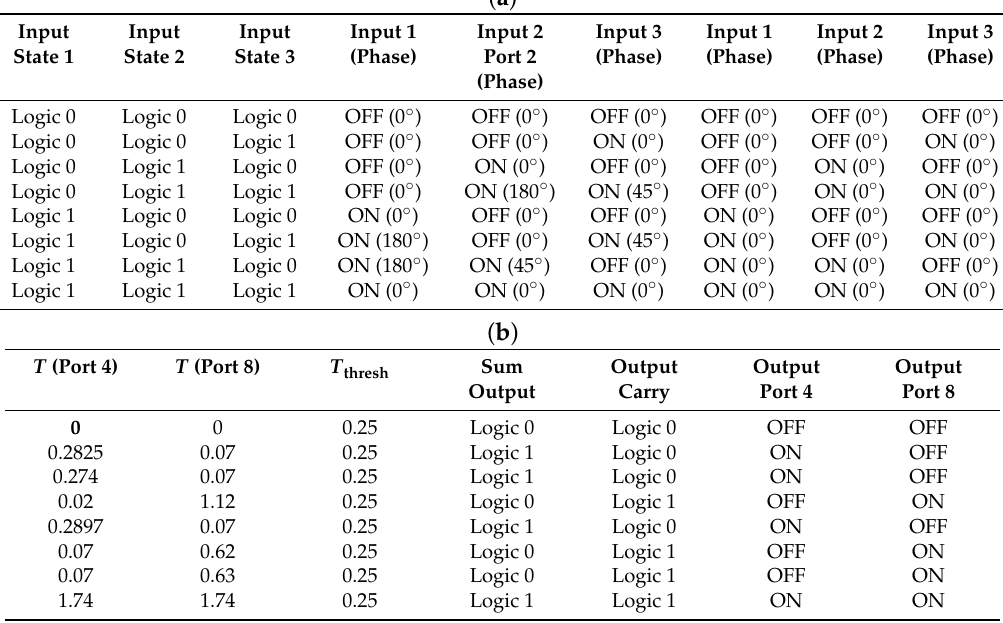
Table 5. Operation of the transmission for the proposed plasmonic full-adder. ( a )